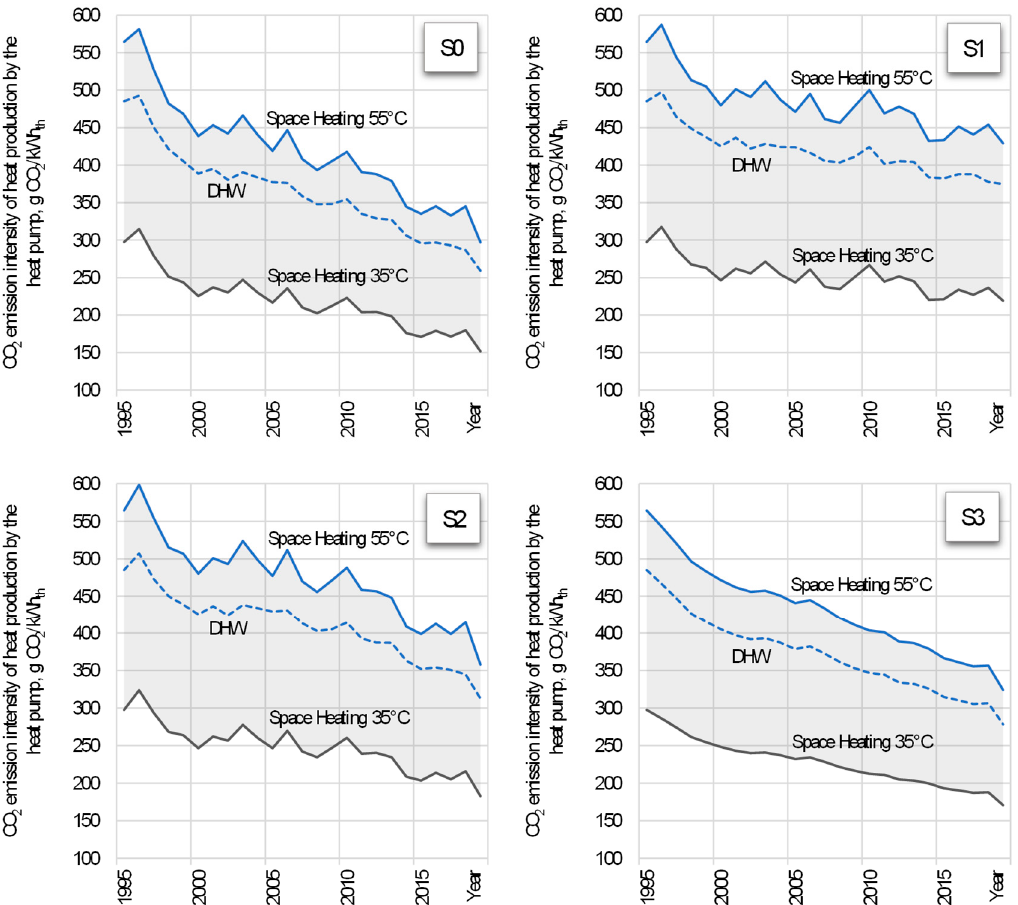
Figure 9. Multi-annual CO ₂ emission intensity of heat generation by heat pump per 1 kWh th of produced thermal energy for different scenarios: ( S0 ) semi-real; ( S1 ) with fixed EI E ; ( S2 ) with fixed COP; ( S3 ) with fixed t e at the 1995 level. Solid blue line represents EI HP in space heating mode with a sink temperature of 55 °C, dashed blue is EI HP in domestic hot water (DHW) preparation mode (supply 55 °C) and the grey line is EI HP in a low-temperature space heating system with a sink temperature of 35 °C; grey area reflects the range of available CO ₂ emission intensities.